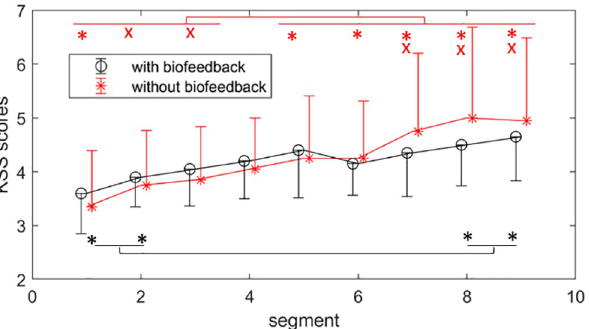
Fig 8. Subjective ratings of fatigue (KSS scores) in the automatic (with biofeedback) and manual (without biofeedback) tasks. The segments with significantly different KSS scores are indicated by the red color for the manual sessions and black color for the automatic sessions ( p < 0.05). The points and error bars respectively represent the mean and standard deviation values across the participants for each